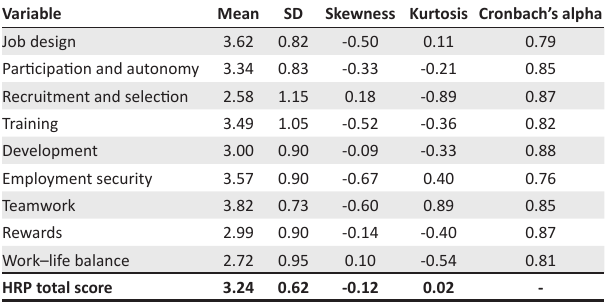
TABLE 5: Descriptive statistics, Cronbach’s alpha coefficient of the factors of the Human Resource Practices Perceptions Questionnaire (adapted structural